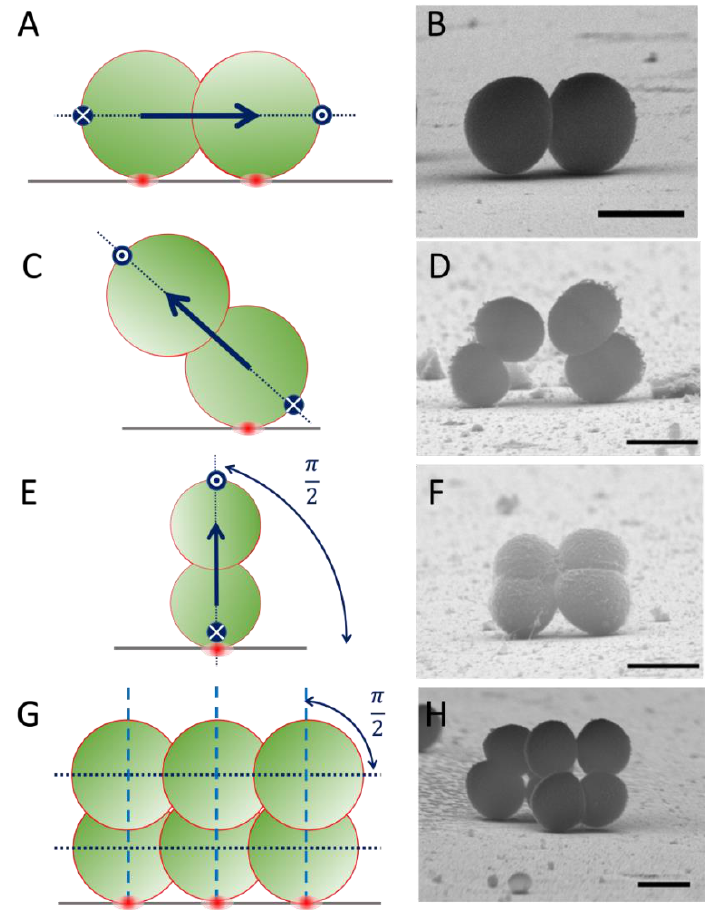
Figure 2. Cell-division of Staphylococcus spp. on flat Si surfaces. Left column: schematic representation of cell division; Right column: representative Scanning Electron Microscopy (SEM) images of staphylococcal cells on flat Si surfaces. ( A – F ) After initial attachment, the symmetry of the cell environment is broken but the cell is able to progress with cell growth and division towards the surrounding environment. The orientation of initial cell-surface attachment (red dot) can determine the direction (blue arrow) of subsequent cell division events on Staphylococcus spp. On flat surfaces, cell growth may occur at any angle relative to the surface plane. ( G , H ) Due to the topological memory of the cell division mechanism of Staphylococcus spp., the 1st generation daughter cells grow in an orthogonal direction with respect to the initial division event. Scale bars 1 µm. Note: (( B ) S. epidermidis ; ( D , F , H) ) S. aureus.